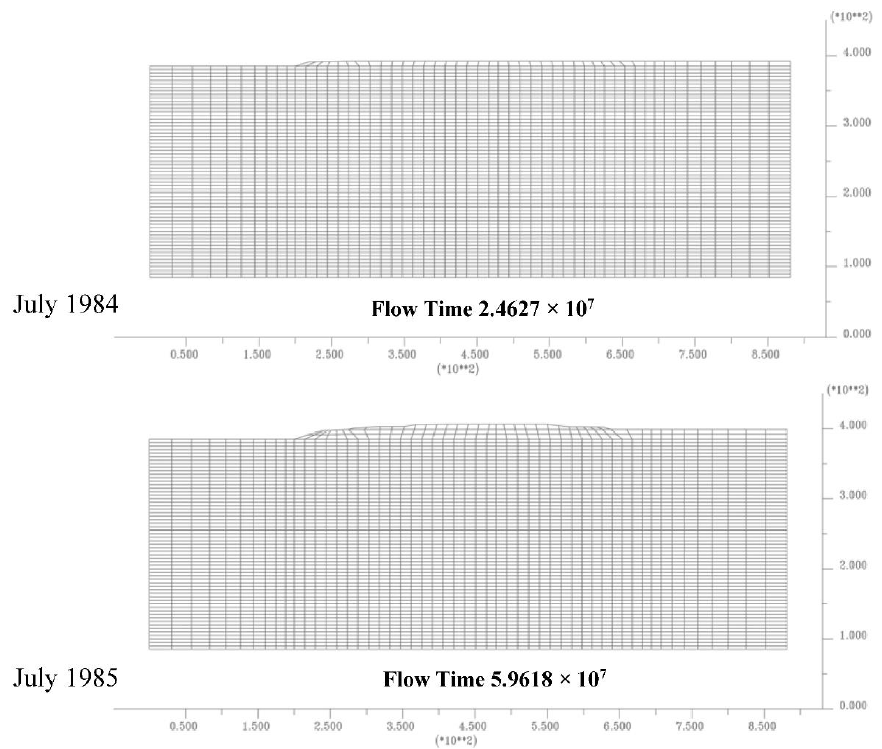
Figure 20. Dam’s construction steps implemented, cofferdam and first layer dam.